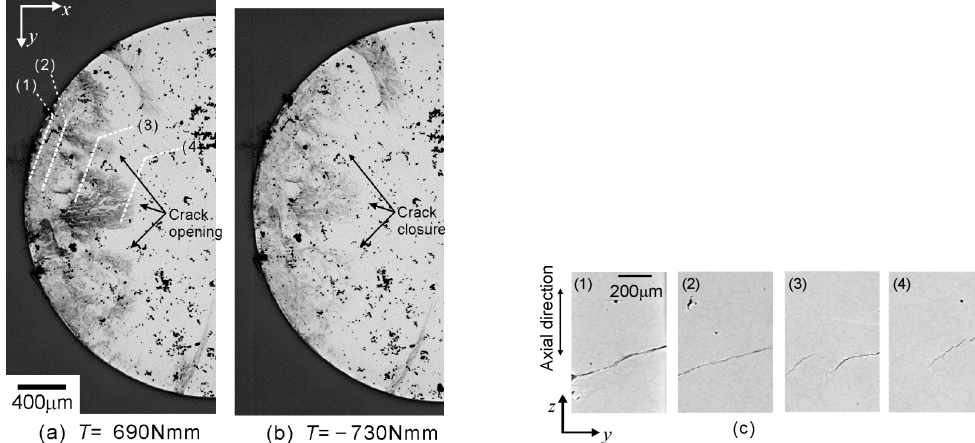
Figure 4: (a) and (b): projection along the z axis of the minimum intensity in the reconstructed volume of the sample after 265k cycles, (c) vertical slice at the positions indicated by the white